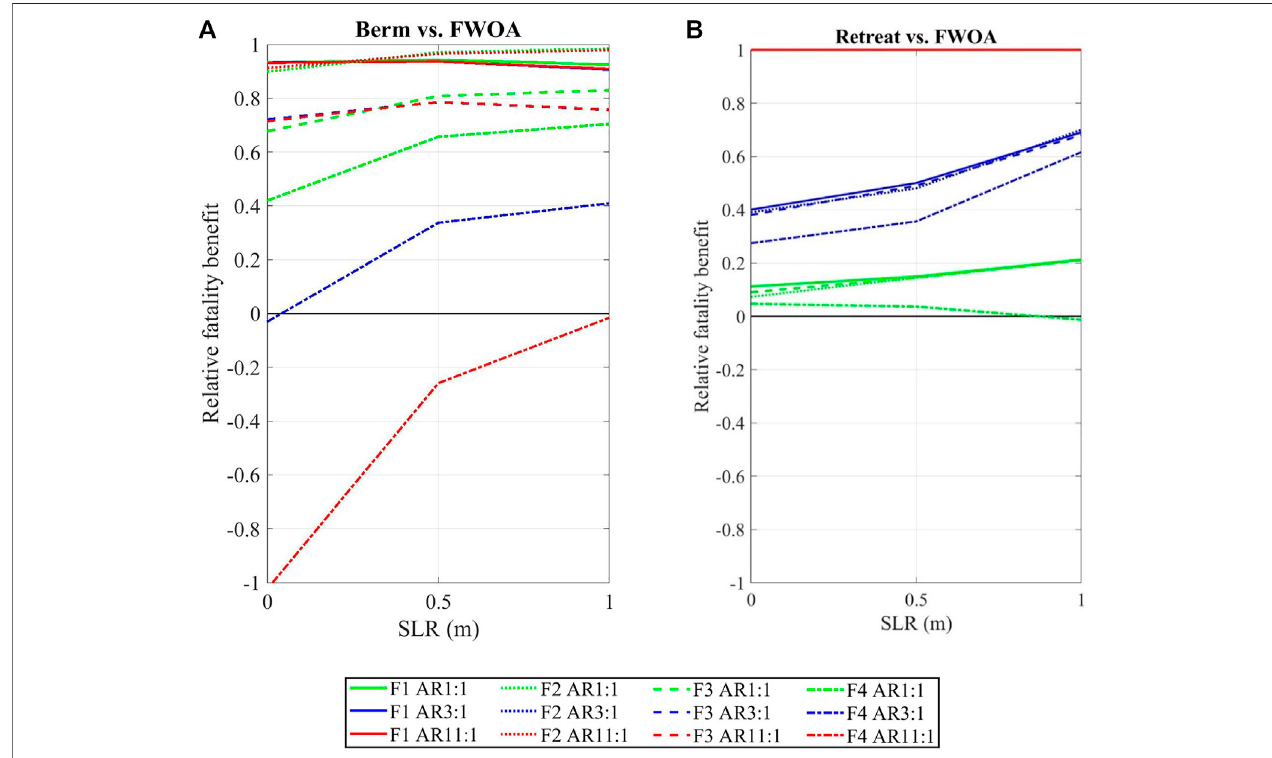
FIGURE4| Relativefatalityreduction(RFR)betweenFWOAand riskreduction measures (A) bermand (B) retreat,forCLaNs withdifferentaspectratios (AR).Four different line types represent results calculated by four different mortality models F 1 (cid:1) f ( D ) ; F 2 (cid:1) f ( D , V ) ; F 3 (cid:1) f ( D , V , W ) ; F 4 (cid:1) f ( W ) .